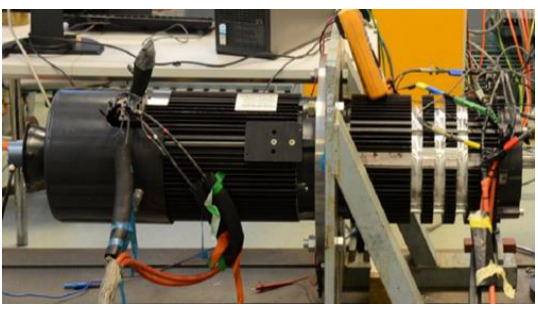
Fig. 5. (a) Experimental setup; (b) Schematic of the experimental setup.